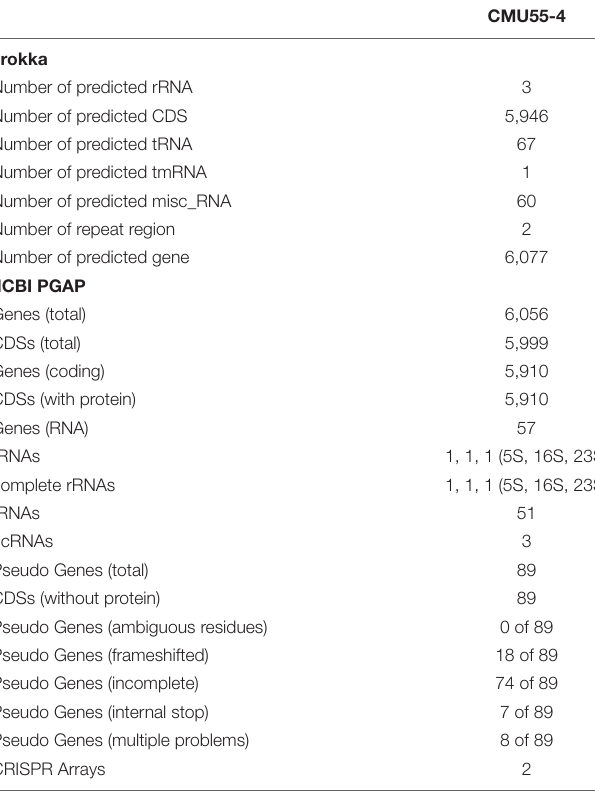
TABLE 4 | Summary of genome annotation of strain CMU55-4. TABLE 5 | Protein coding sequences related with plant growth promoting traits of M. chalcea